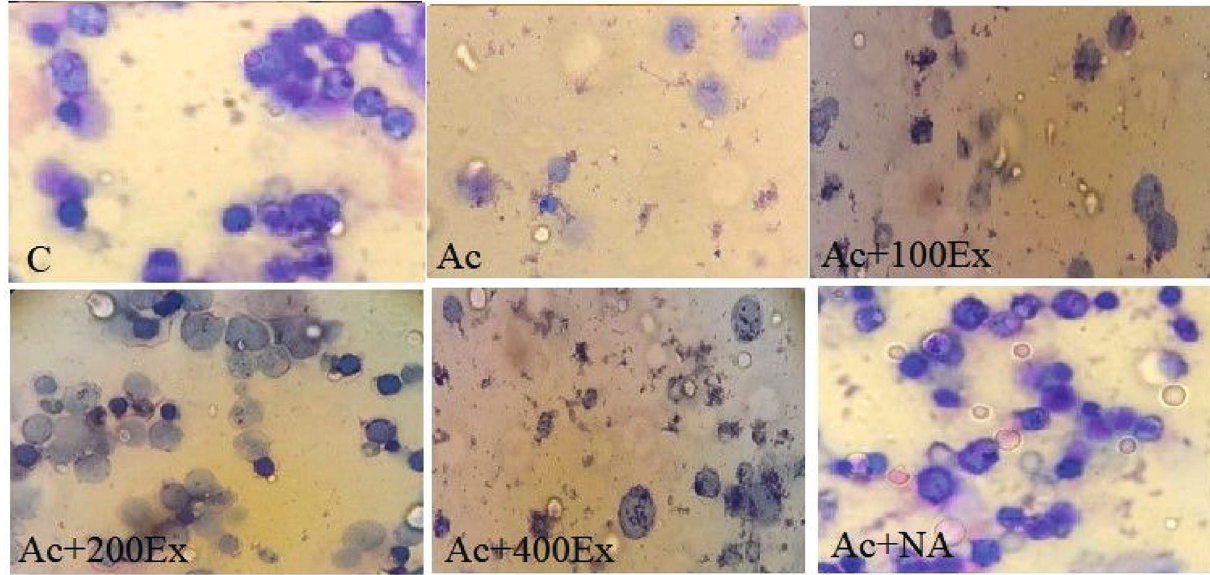
Figure 4: The status of bone marrow cells in di ff erent groups. Microscopic view of animal ’ s bone marrow cells in the groups (trypan blue staining, × 400 magni fi cation). C (the average number of cells is normal (normocytosis)), Ac (cell counts are reduced signi fi cantly and cellular toxicity (hypocytosis)), Ac +100Ex (reduction of the cell counts), Ac+ 200Ex (cell counts are increased and change to normocytosis), Ac +400Ex (cell counts are decreased and cell toxicity), and Ac +NA (cell counts are increased and shift to normocytosis).